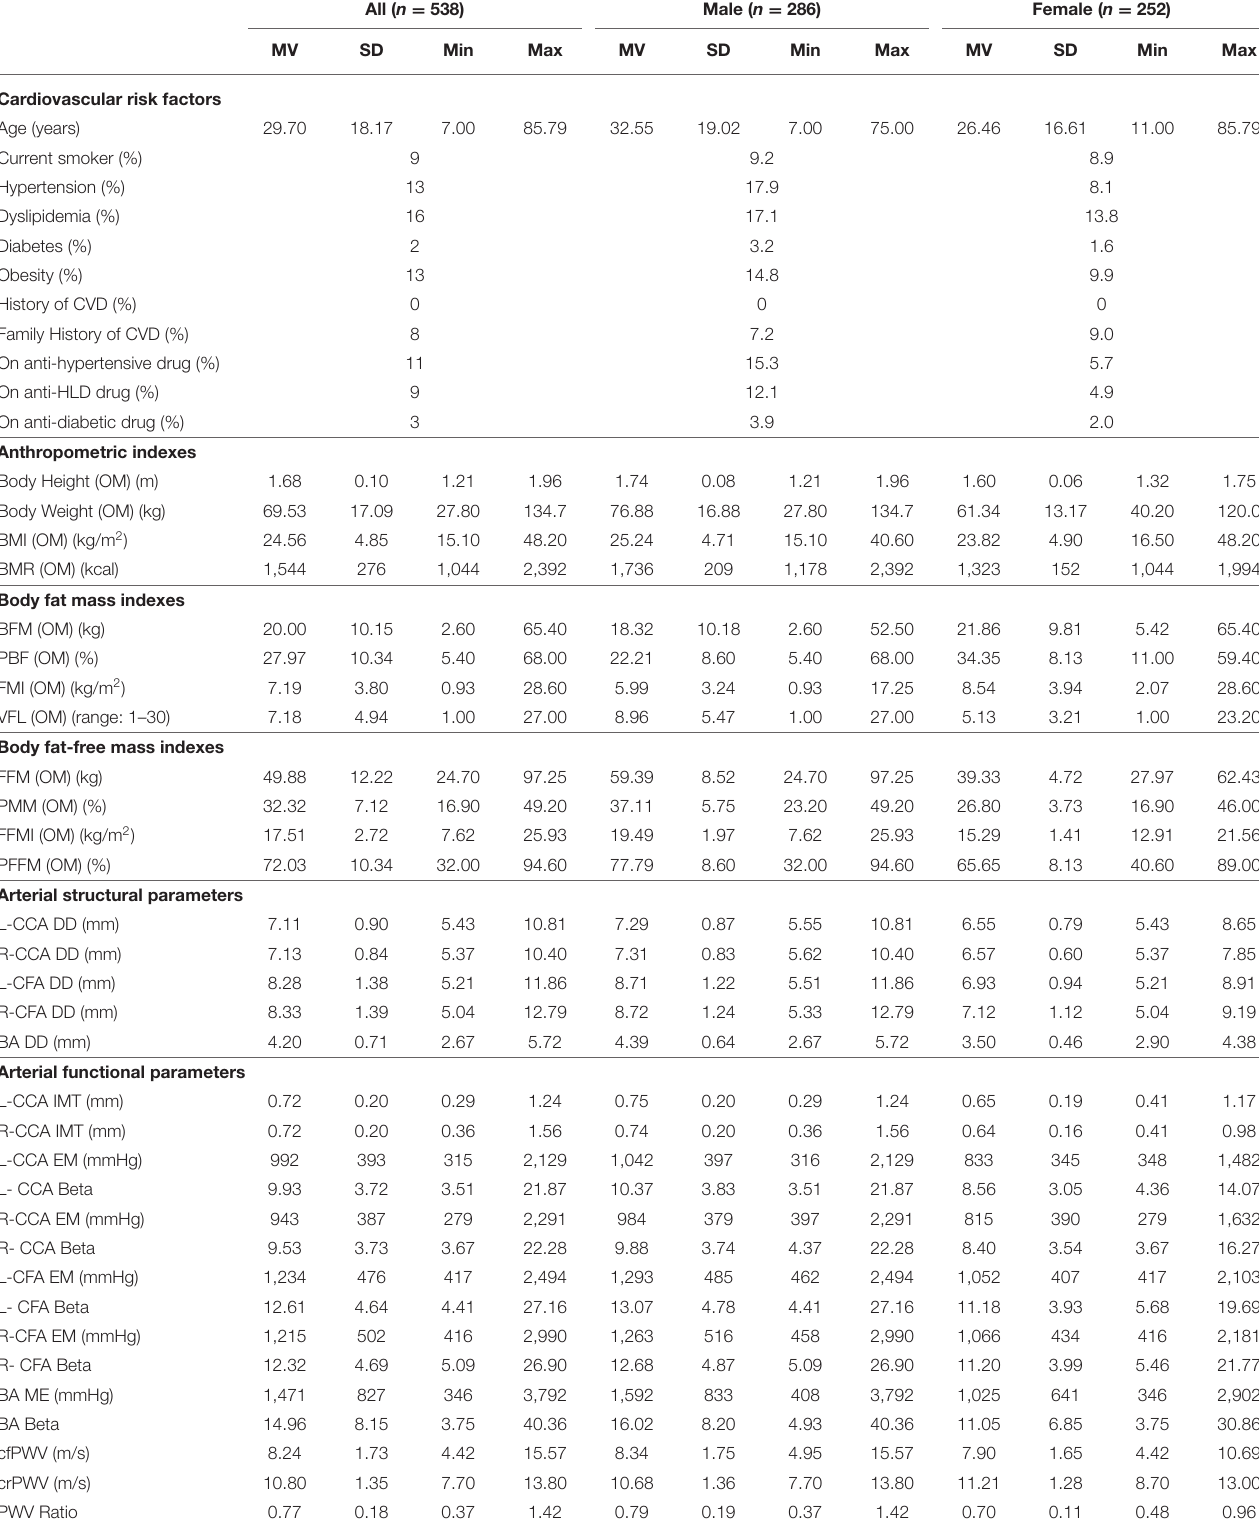
TABLE 1 | Characteristics of subjects evaluated by bioelectrical impedance analysis (OMRON HBF-514C